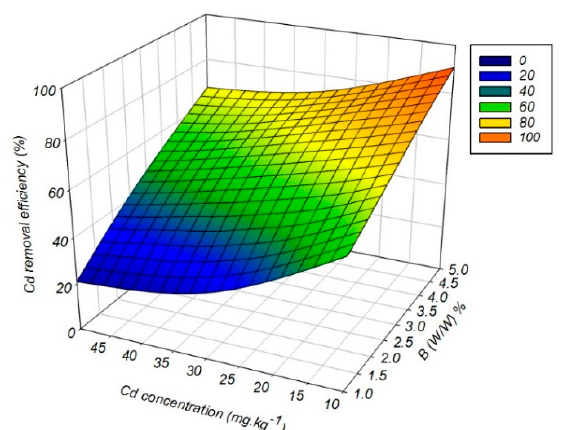
Figure 7. Cadmium removal efficiency as a function of Cd contamination level and biochar amendment level.